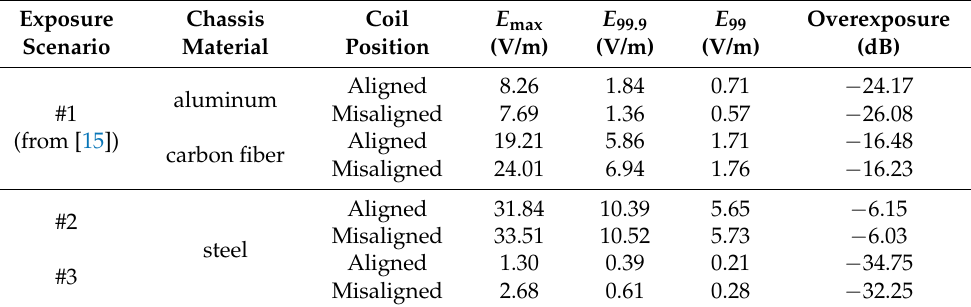
Table 1. Summary of the compliance with the BR for the considered exposure